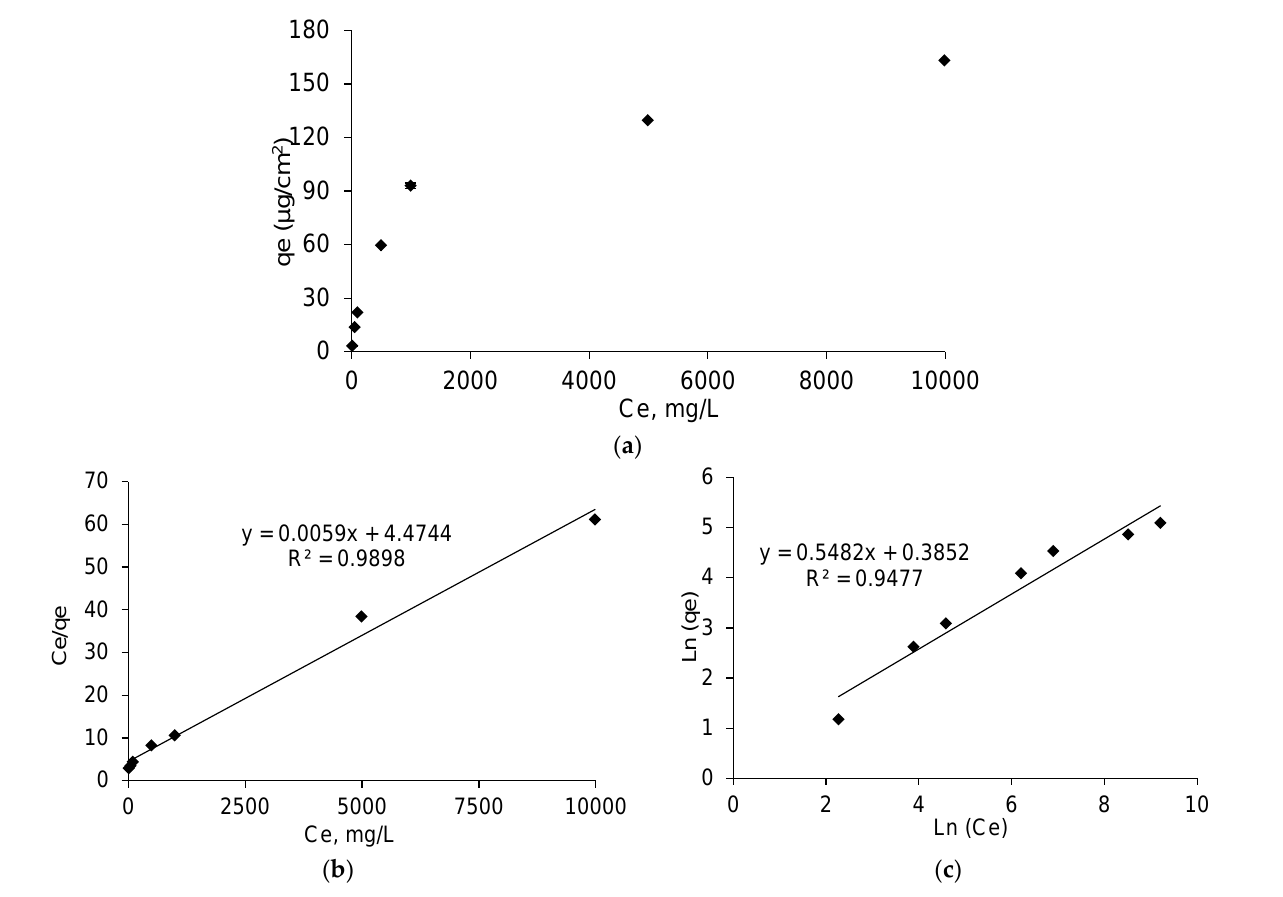
Figure 5. ( a ) Adsorption isotherm of IBU-L onto PET-CD-Ag-PEM dressings after 24 h of impregnation at 240 rpm at room temperature. ( b ) the Langmuir isotherm of adsorption, and ( c ) Freundlich isotherm of adsorption.